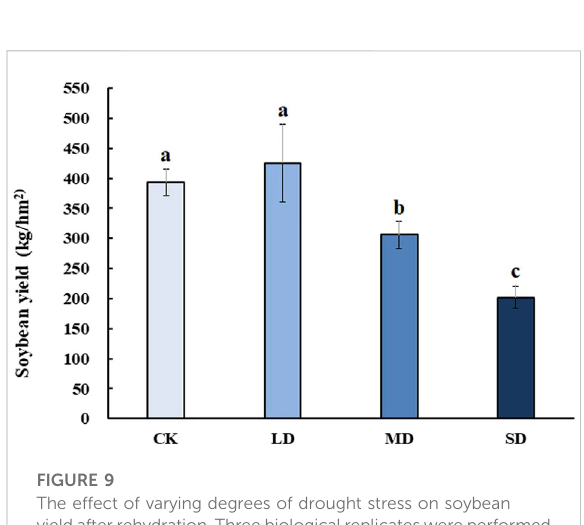
FIGURE 9 The effect of varying degrees of drought stress on soybean yield after rehydration. Threebiologicalreplicateswereperformed andthedatarepresentthemeans±SDs.Differentlettersrepresent statistically signi fi cant differences ( p <